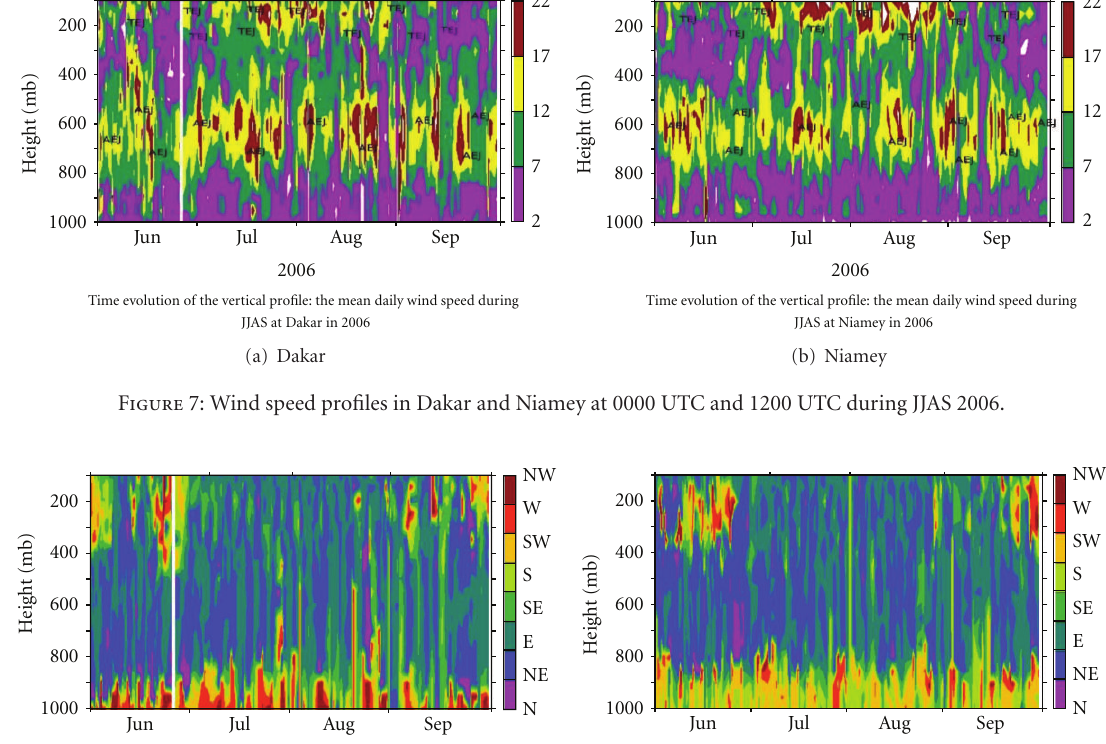
Time evolution of the vertical profile: the mean daily wind direction during JJAS at Dakar in 2006